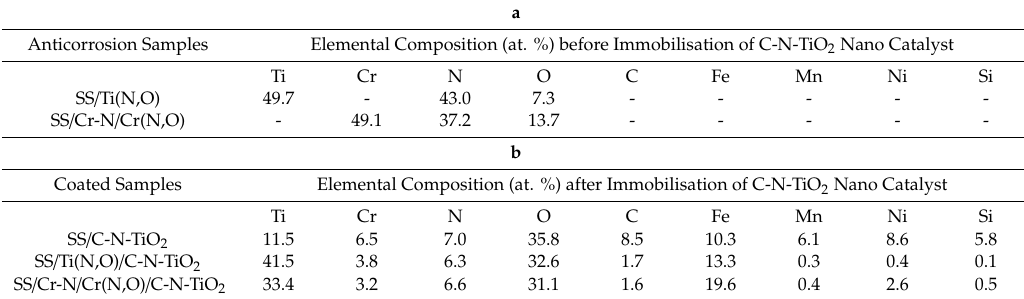
Table 1. a: Normalised elemental composition of coated stainless steel before photo catalysis (at.% = atomic percentage); b: Normalised elemental composition of C-N-TiO 2 coated stainless steel and anticorrosion meshes after photo catalysis. a Anticorrosion Samples